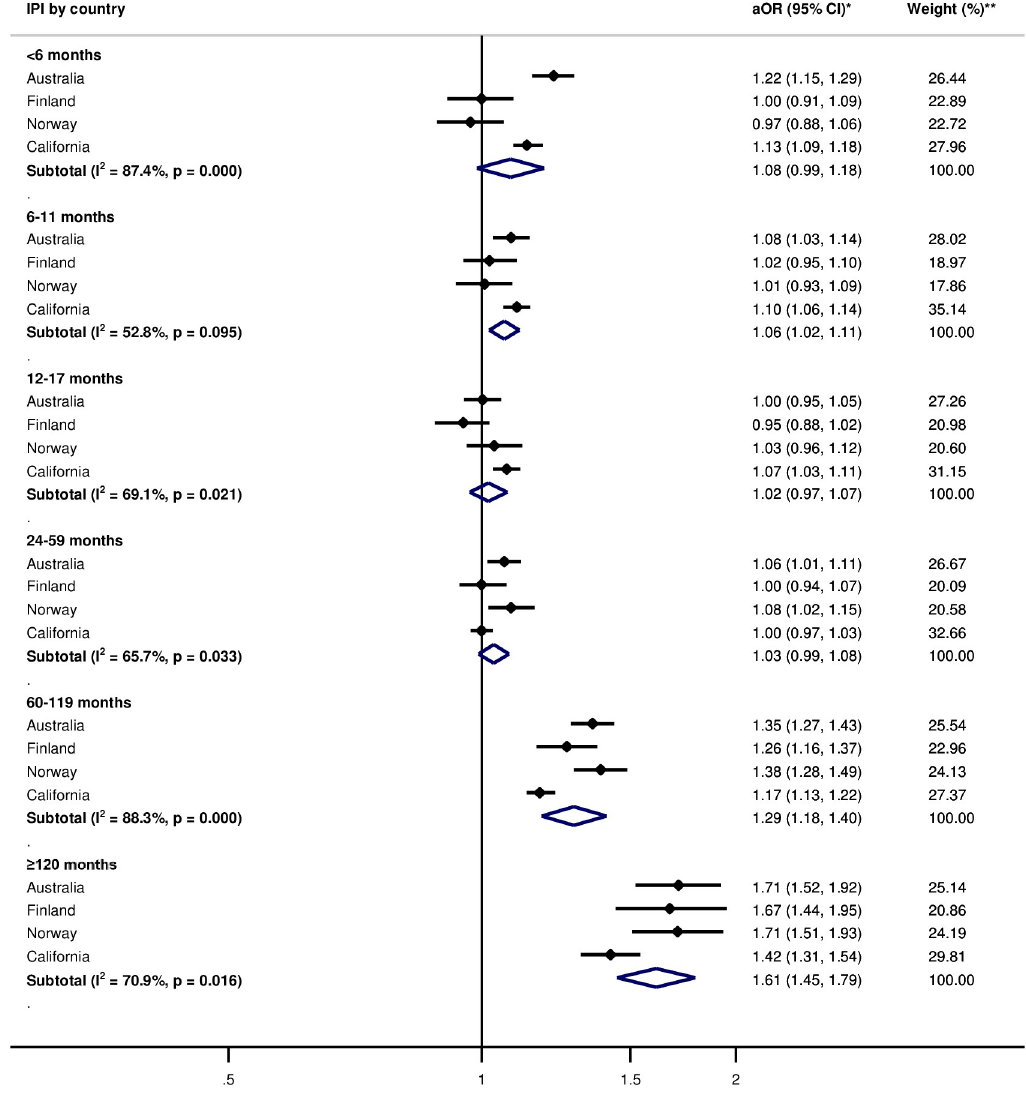
Fig 1. Adjusted odds ratios of within-women analysis for the association between interpregnancy interval and preterm birth as compared to 18–23 months interpregnancy interval by country. IPI—Interpregnancy interval. � Adjusted Odds ratios (aOR) and corresponding 95% confidence intervals, adjusted for maternal age, parity, and birth year; the reference IPI category is 18–23 months. �� Weights are derived from inverse-variance.